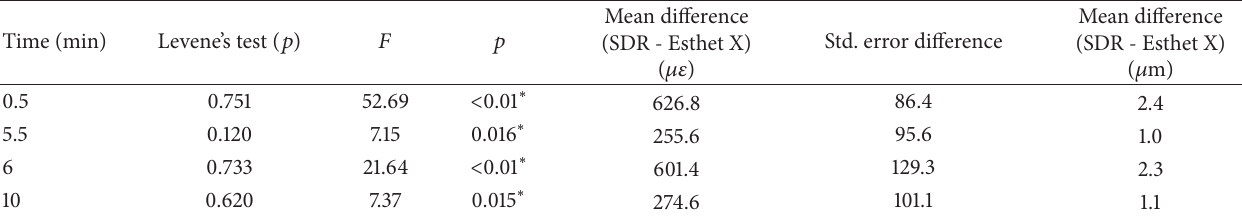
Table 3: Mean differences of deformation for samples restored with Esthet ∙ X (cid:2) HD and SDR (cid:3) , for each time period (ANCOVA).